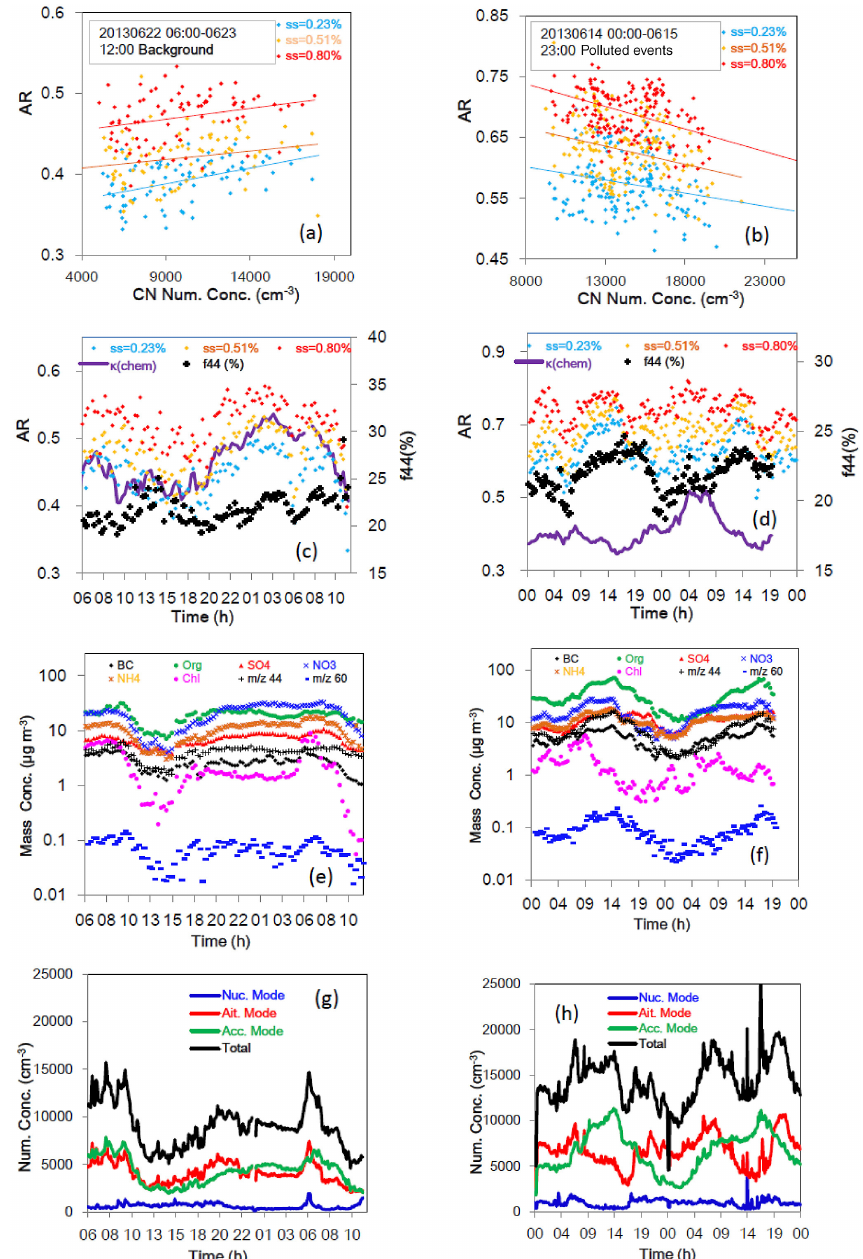
Figure 8. Measurements made under background conditions (22–23 June 2013, N CN <15000cm − 3 ) and polluted conditions (14–15 June 2013, N CN >15000cm − 3 ) . Bulk CCN activation ratios at SS = 0.2, 0.5, and 0.8% as a function of N CN under background and polluted conditions are shown in (a) and (b) , respectively. Diurnal variations in AR, derived from κ chem and the fraction of total organic mass signal at f 44 , under background and polluted conditions are shown in (c) and (d) , respectively. Mass concentrations of black carbon (BC), organics, ) , ammonium (NH + ) , sulfate (SO 2 − ) , chloride (Cl − ) ions, etc., under background and polluted conditions are shown in (e) nitrate (NO − 3 4 4 and (f) , respectively. N CN for nucleation (10–30nm), Aitken (30–130nm), and accumulation modes (130–700nm) under background and polluted conditions are shown in (g) and (h) ,